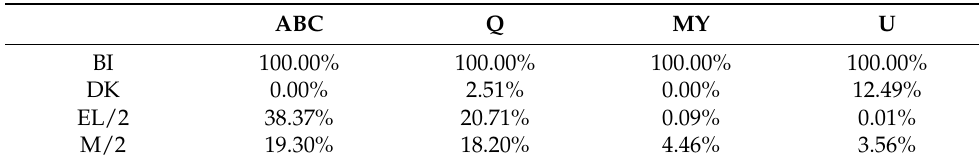
Table 2. Assessment of the W-ORK+ group arrangements.